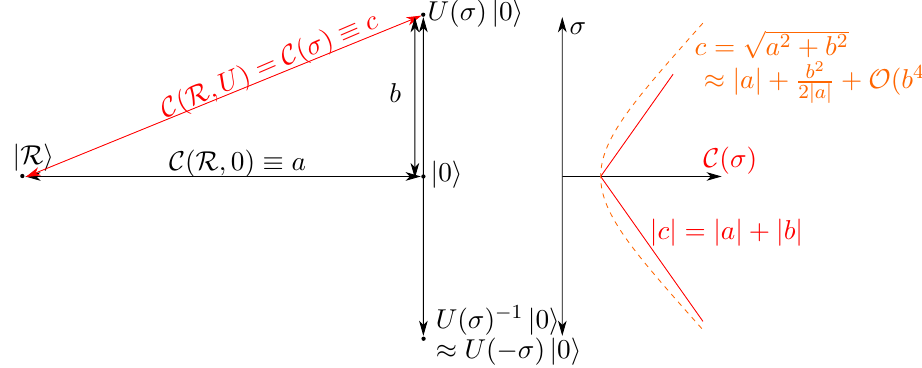
Figure 5 . Possible interpretation of order O ( (cid:27) 2 ) and O ( (cid:27) ) terms in (cid:14) C . A change of order (cid:14) C / (cid:27) log( (cid:27) ) however would seem very hard to interpret in terms of a plausible distance measure on the Hilbert space, especially as it would mean (cid:14) C < 0